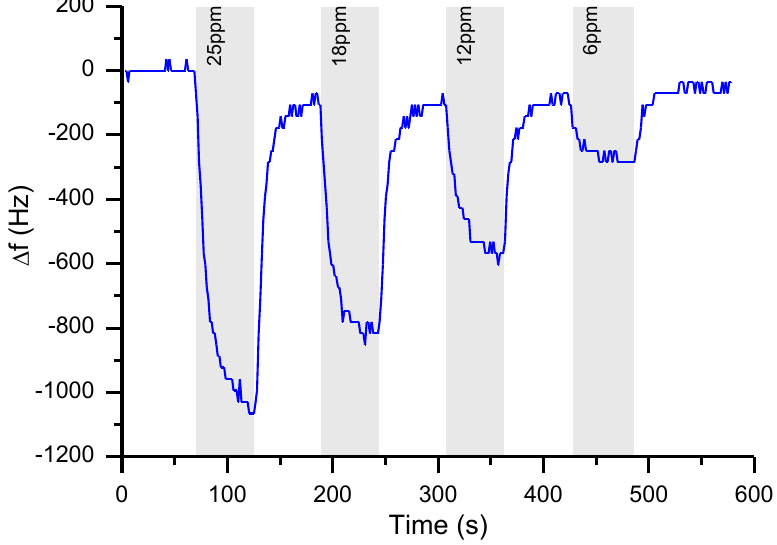
Figure 2. Typical curve for the detection of various TATP concentrations by a polyphenylene dendrimer; gray shaded areas represent time slots during which the analyte was